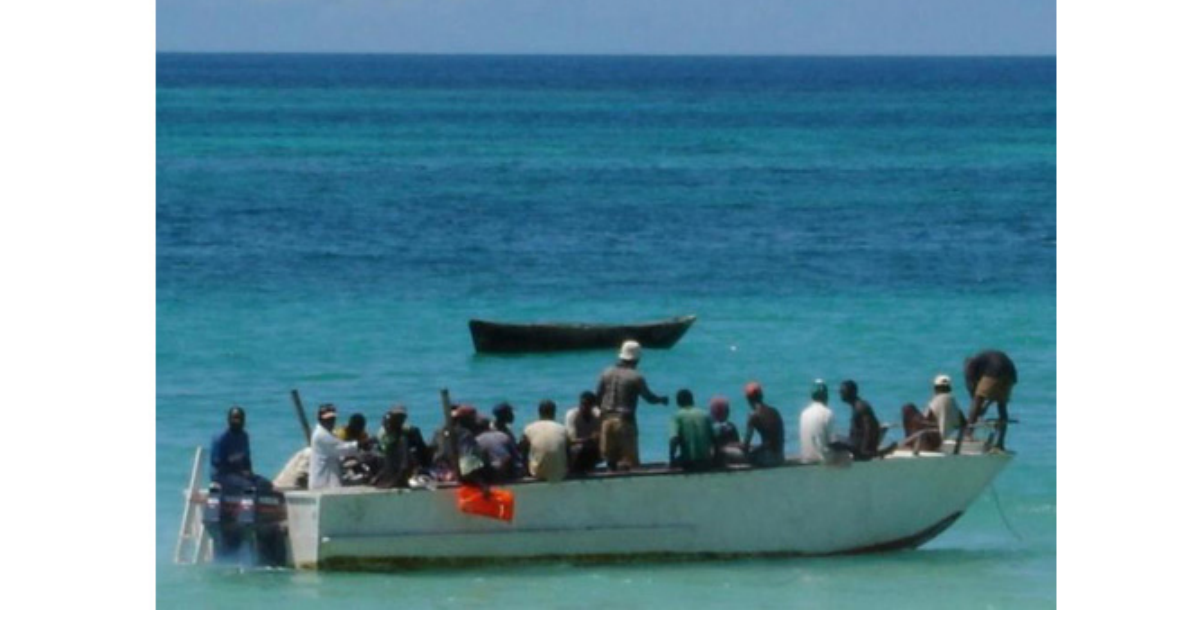
Fig. 3. A “modern” plywood boat donated to fishers in Diani–Chale contrasted against a traditional canoe. Photo by Louisa